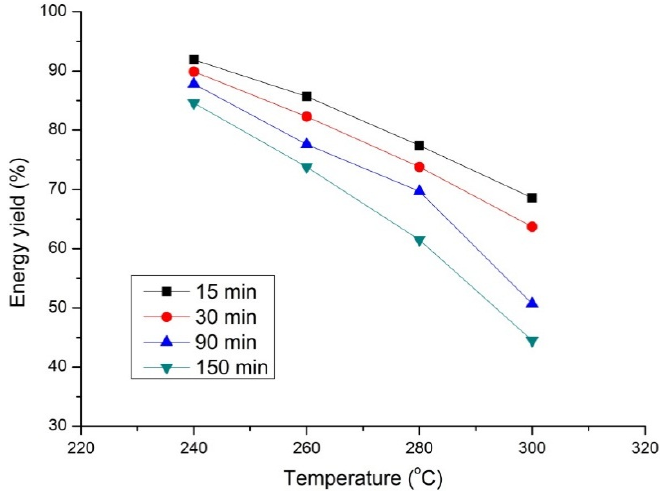
Figure 9. Energy yield of beech wood with temperature at four different torrefaction and residence